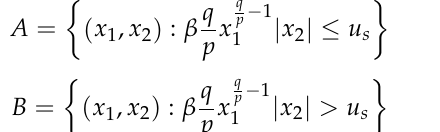
Figure 2. x 1 for different values of x 2 ( q = 3 and p = 5 ). Figure 2.